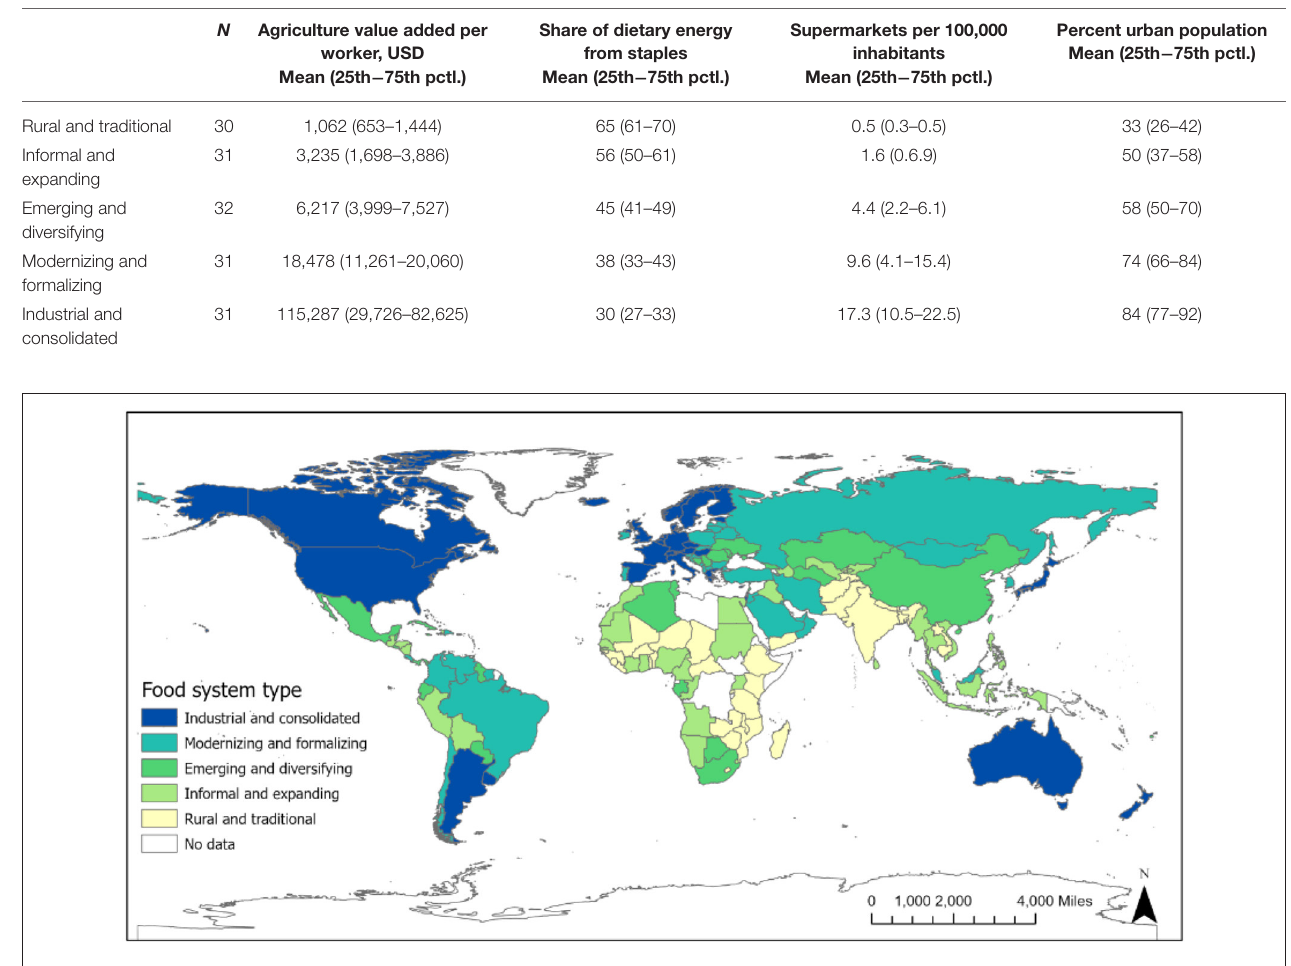
TABLE 2 | Summary statistics by food systems type.